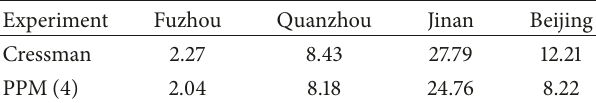
Table 6: The MAE ( 𝜇 g/m 3 ) of four representative stations before and after